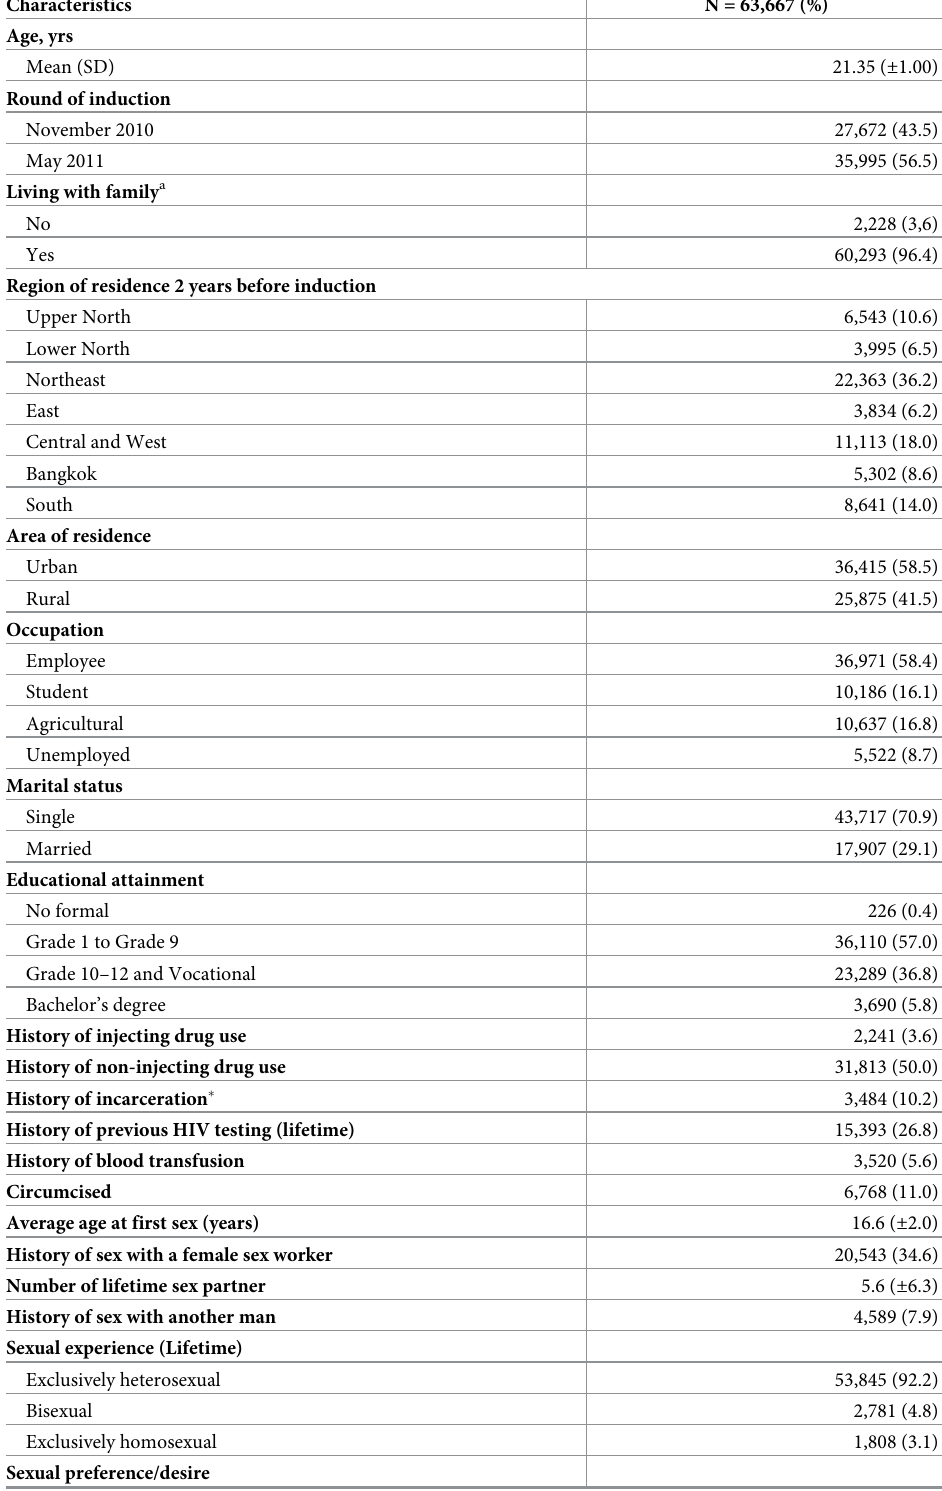
Table 1. Demographic and behavioral profile of the participants before